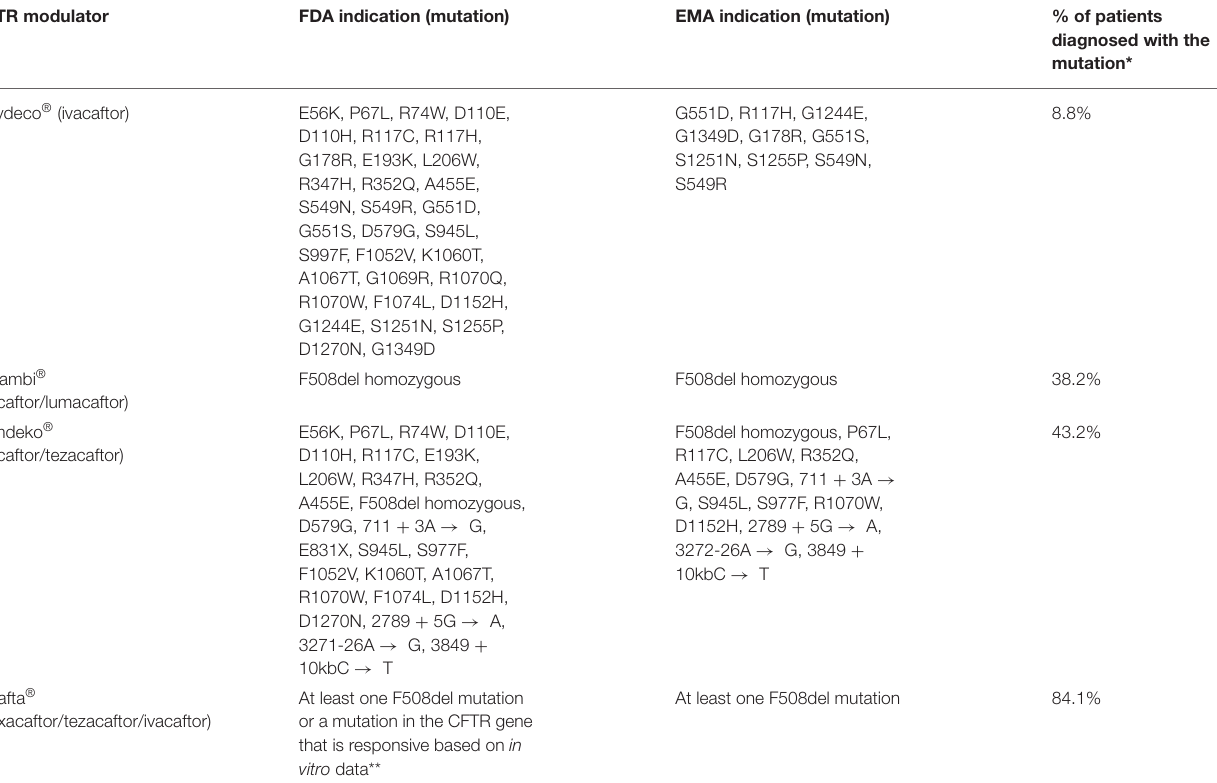
TABLE 1 | Proportion of patients on the CFTR2 platform who are candidates for the use of CFTR modulators as recommended by the US Food and Drug Administration (FDA) and European Medicines Agency (EMA). CFTR modulator FDA indication